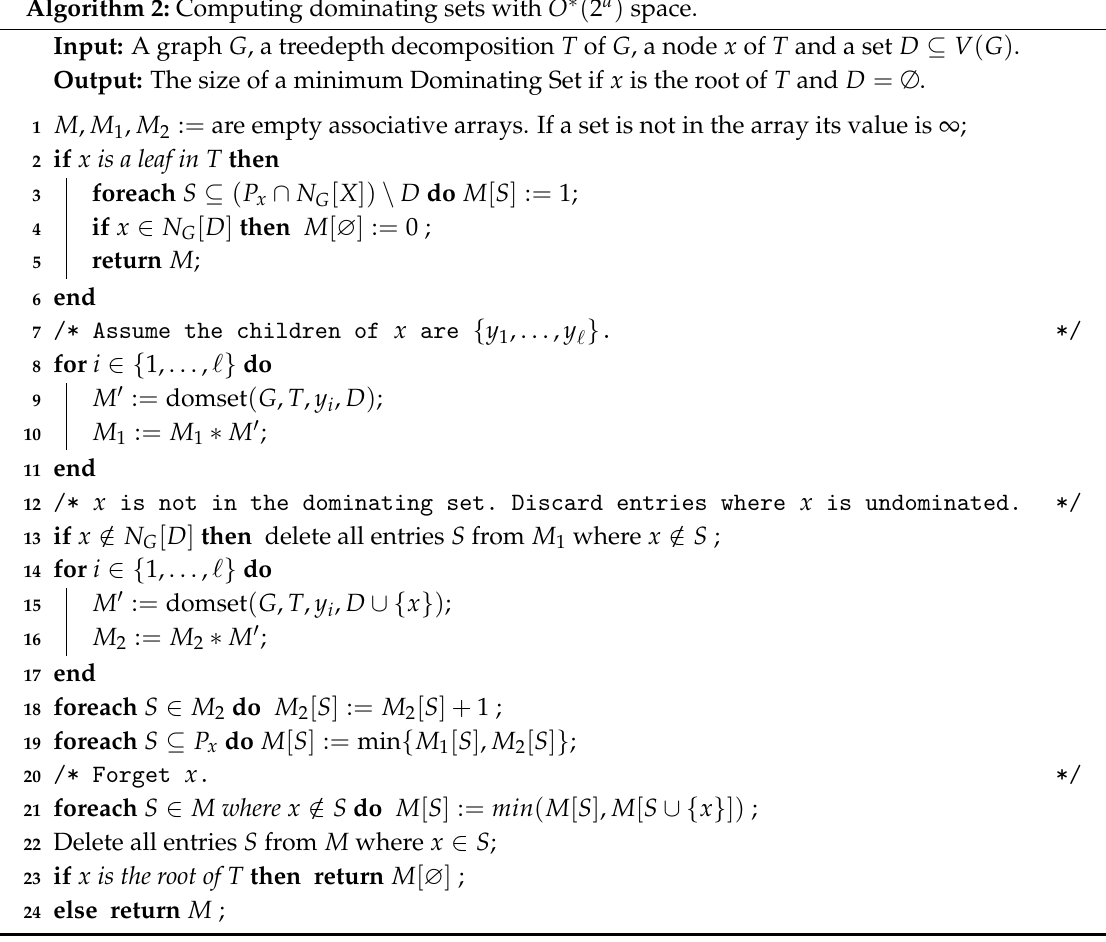
Algorithm 2: Computing dominating sets with O ∗ ( 2 d )